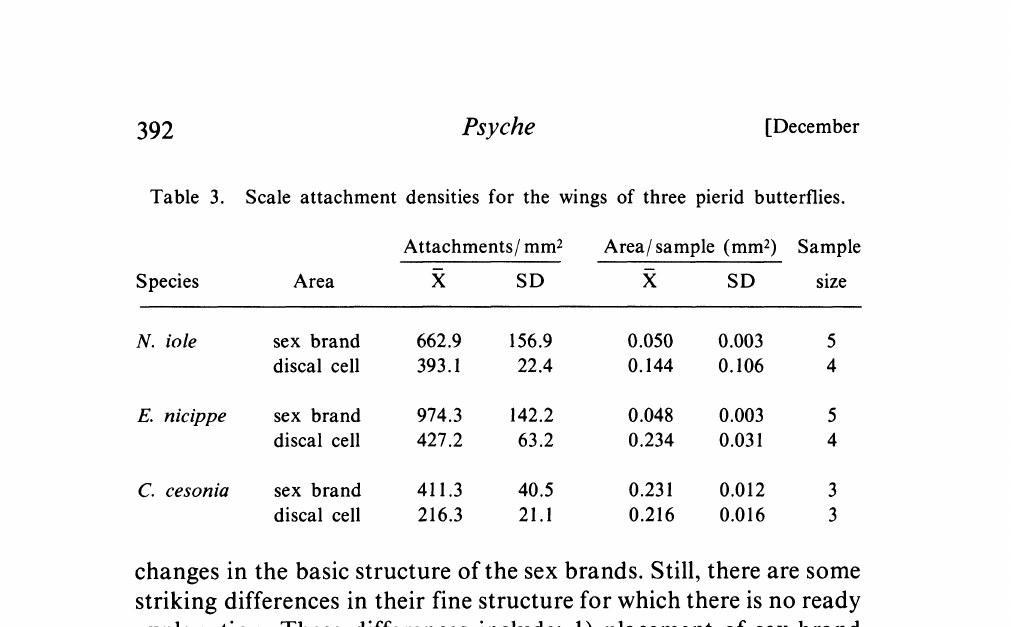
Table 4. The relationship between sex brand color and wing condition in E. nicippe. Sex brand color (no. of males) Wing Half orange, Condition Orange Half white